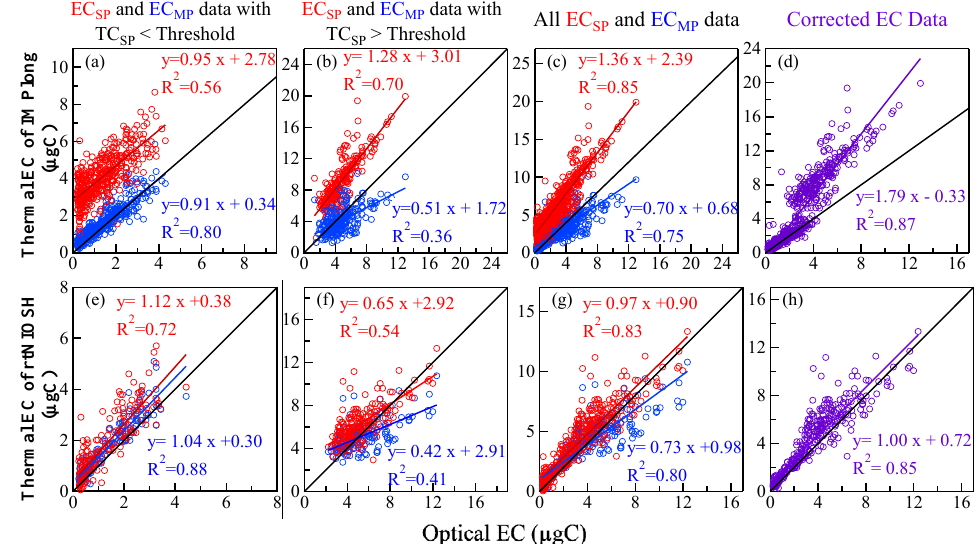
Figure 6. Thermal EC data, including EC SP , EC MP and corrected EC, plotted against Optical EC for (a)-(d) IMPlong protocol, and (e)-(h) rtNIOSH protocol. Linear regression of both EC SP and EC MP with Optical EC was done for (a)(e) data with corresponding TC SP < Threshold, (b)(f) data with corresponding TC SP > Threshold carbon, and (c)(g) all data, respectively. Correlation of corrected EC with Optical EC (d)(h) was also shown for comparison. The 1:1 line was shown for reference.